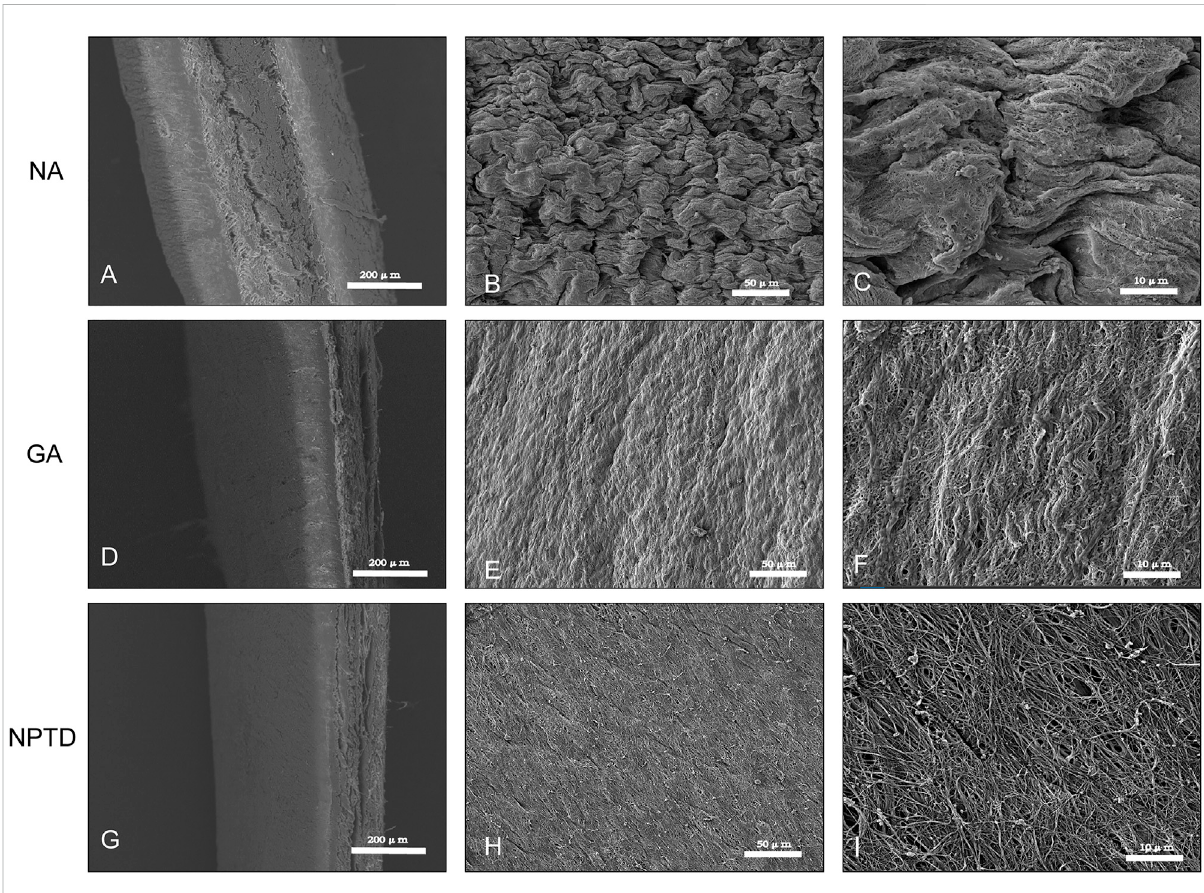
FIGURE 3 SEMmicrograph ofthesurfaceandtransectionofthebovinepericardium.Thetissue featureoftheNAwasthelooseporousandrough (A,B,C) . The feature of fl at and compact structure in the NPTD group (G,H,I) was similar to that of the GA group (D,E,F) .